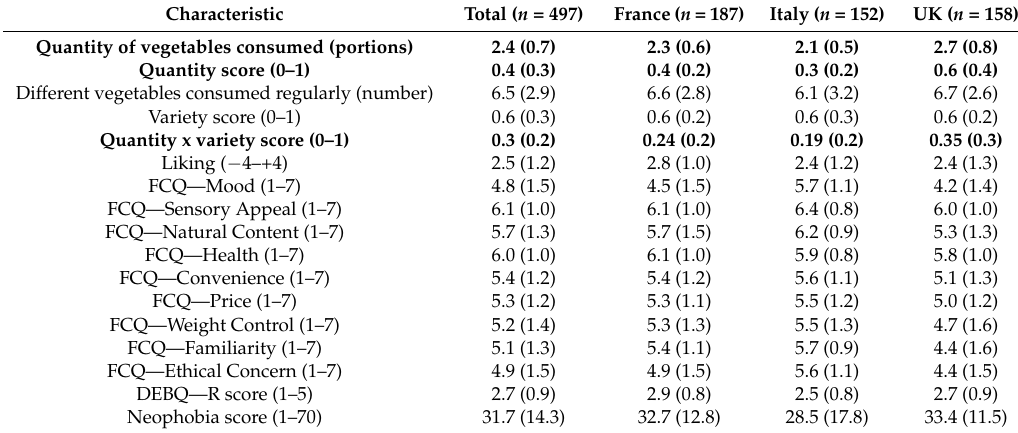
Table 2. Descriptive statistics (mean, standard deviation) for quantity and variety of vegetable consumption and all attitudinal variables in all three countries ( n =